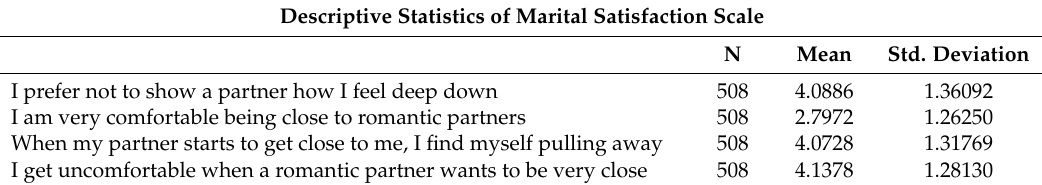
Table 2. Descriptive Statistics of Variables